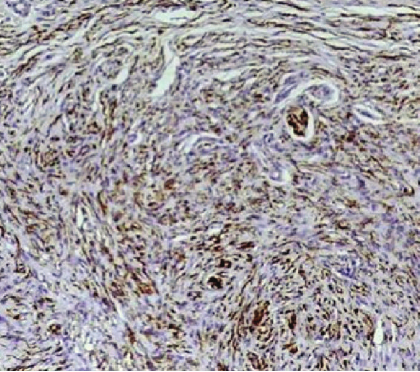
Figure 6: S-100 positivity for nerve tissue and spindle cells